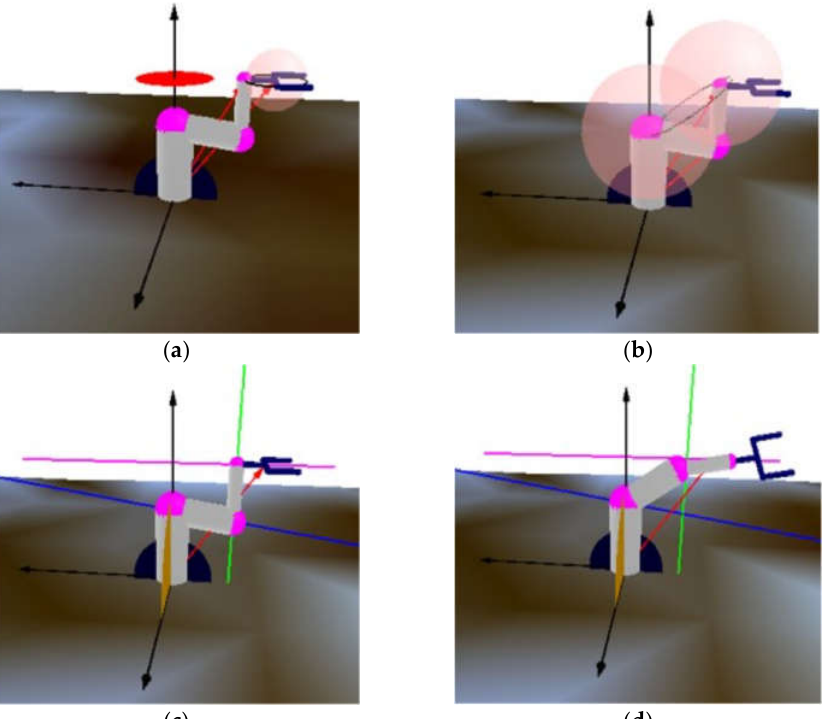
Figure 6. Inverse kinematics algorithm: ( a ) computation of the joint point p 2 ; ( b ) computation of the joint point p 1 ; ( c ) computation of the joint angles; ( d ) robot rotation. Table 9. Grasping algorithm